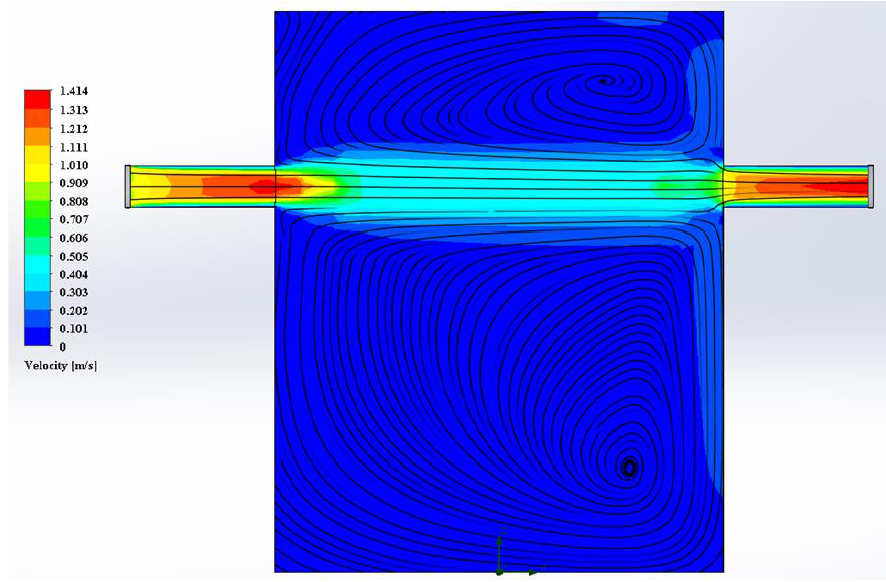
Figure 13. Air velocity in reaction cell and current lines, in run 1, for the geometry with lateral air